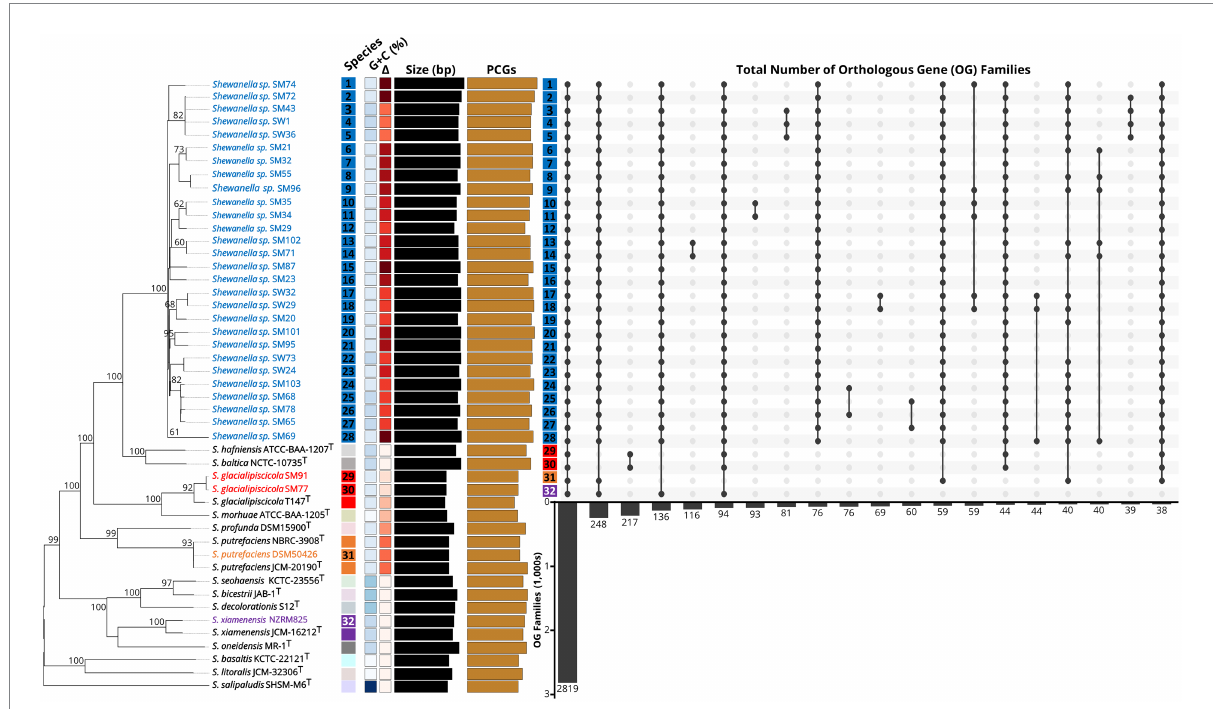
FIGURE 1 Phylogenomic species-tree reconstruction and homologous gene families of the Shewanella genomes. The phylogenomic tree (left) inferred with GBDP displays the pseudo-bootstrap support values from 100 replications above the branches. Type species are indicated with a superscripted T. The colored boxes to the right of each name refer to the species determined by dDDH cutoffs of 70 and 79%, respectively. The gradients further right indicate G + C content (blue) and Δ statistics (red) indicate overall low (light) to high (dark) accuracy of phylogenetic likeness. Black bars represent the approximate genome size and brown bars the protein-coding genes (PCGs). Genome names are colored to represent putative species grouping. The top 20 orthologous gene (OG) families across all 32 Shewanella proteomes is shown on the far right. Dark circles represent presence of OGs across genomes and total number of gene families shown in numbers below the